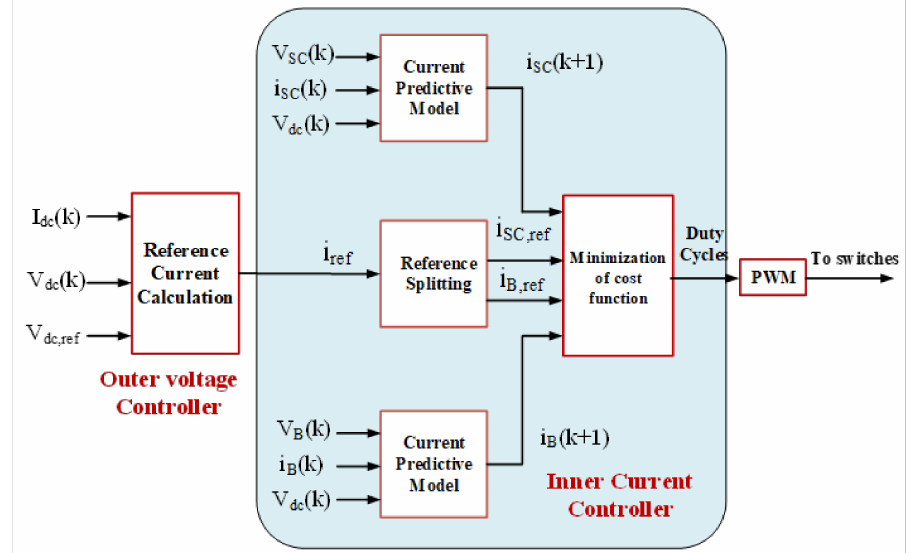
Figure 11. Block diagram representation of MPC for